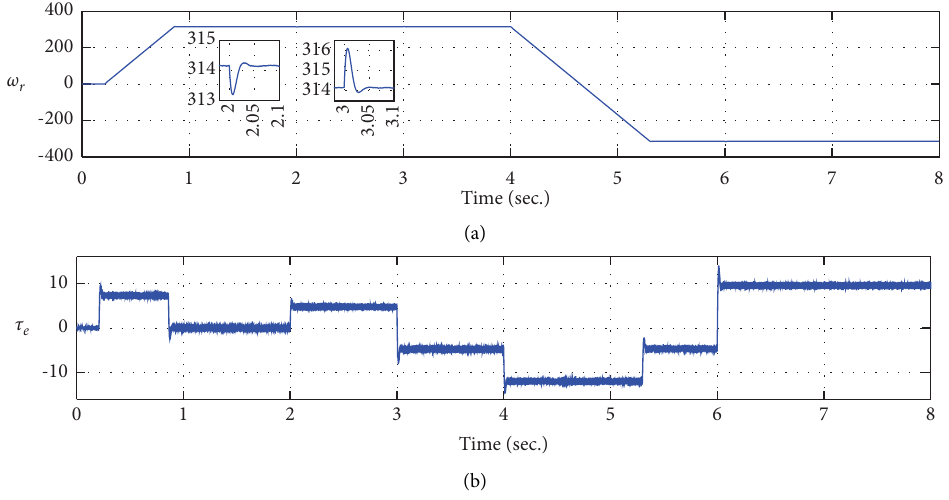
Figure 4: Motor response showing (a) rotor speed ω